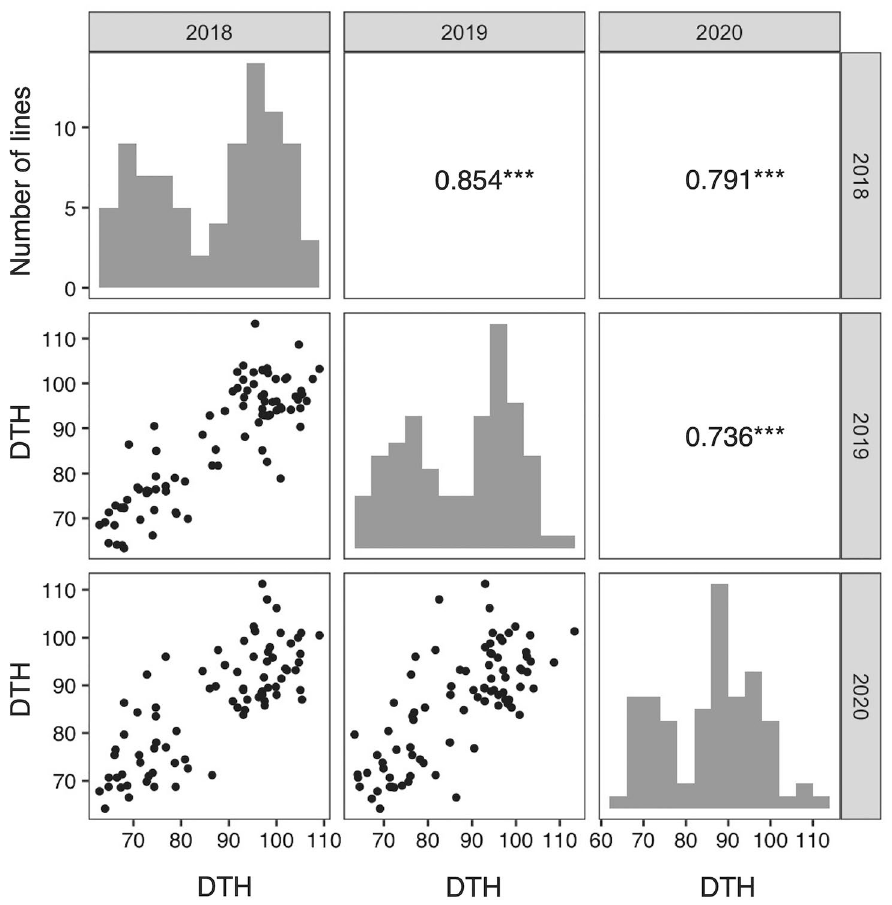
Figure 2. Histograms showing variation of DTH in foxtail millet RILs in 2018, 2019, and 2020 and correlation between different years. The diagonal from the upper left to the lower right : Histograms showing variation DTH in foxtail millet. Upper right: Correlation coefficients between different years. *** P < 0.001. Lower left: Scatter diagrams of DTH of RILs between different